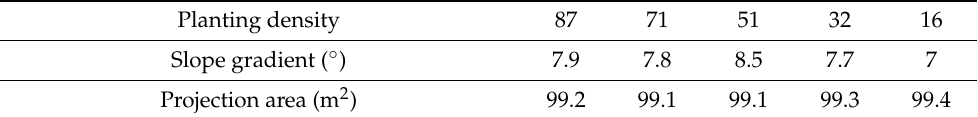
Figure 1. The location of the study area on the Chinese Loess Plateau. Table 1. Slope and canopy projection area of Caragana korshinkii at different planting densities. (shrubs per 100 m 2 ).